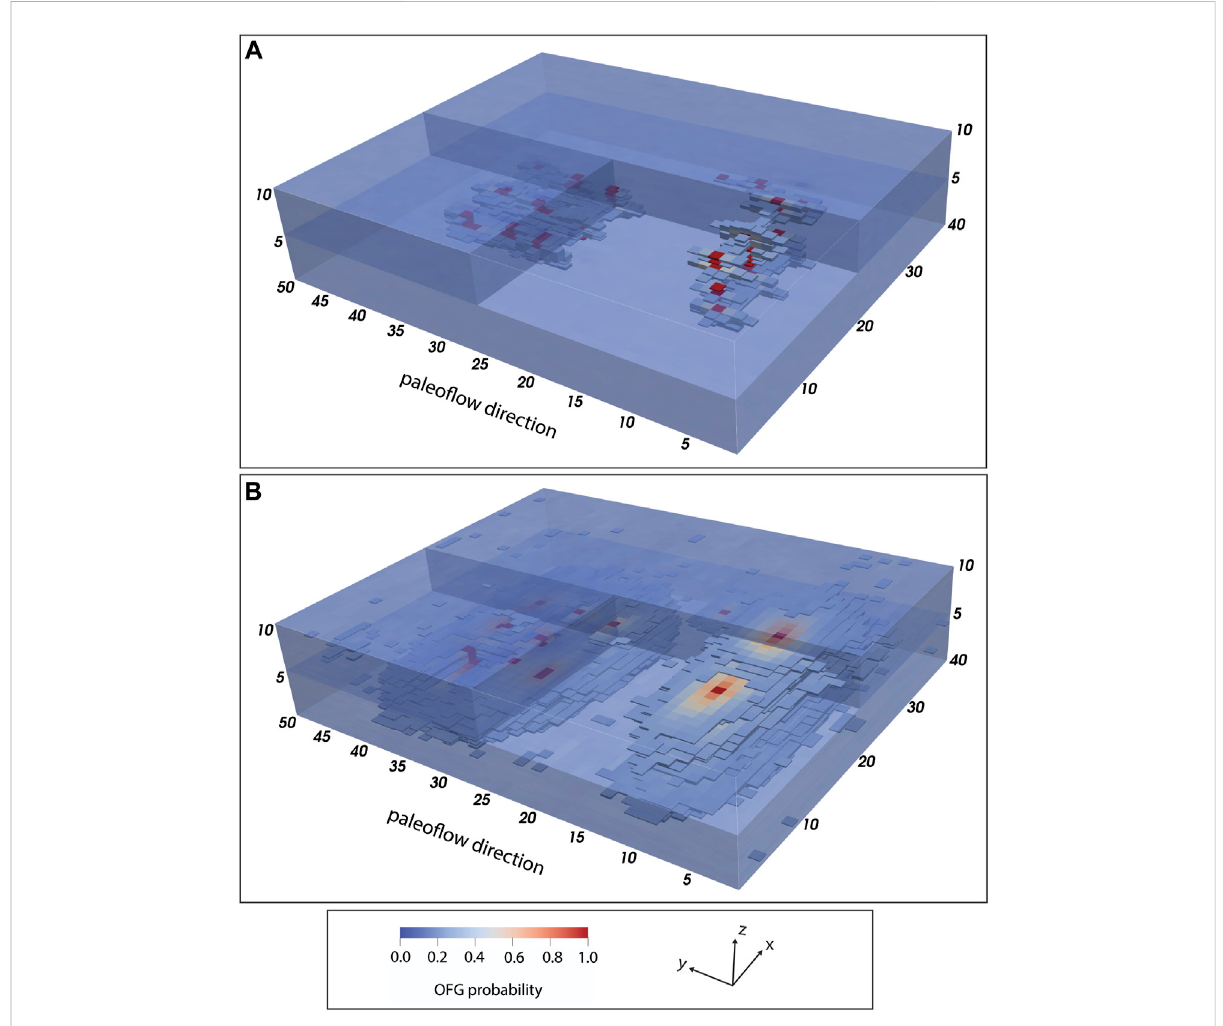
FIGURE 6 OFG probability models showing the spatial probability of OFGs occurring at a probability of greater than 0.25: (A) for combined realizations from TP models labelled ‘ a ’ to ‘ I ’ in Table 1; and (B) for realizations from a single TP model labelled a0 in Table